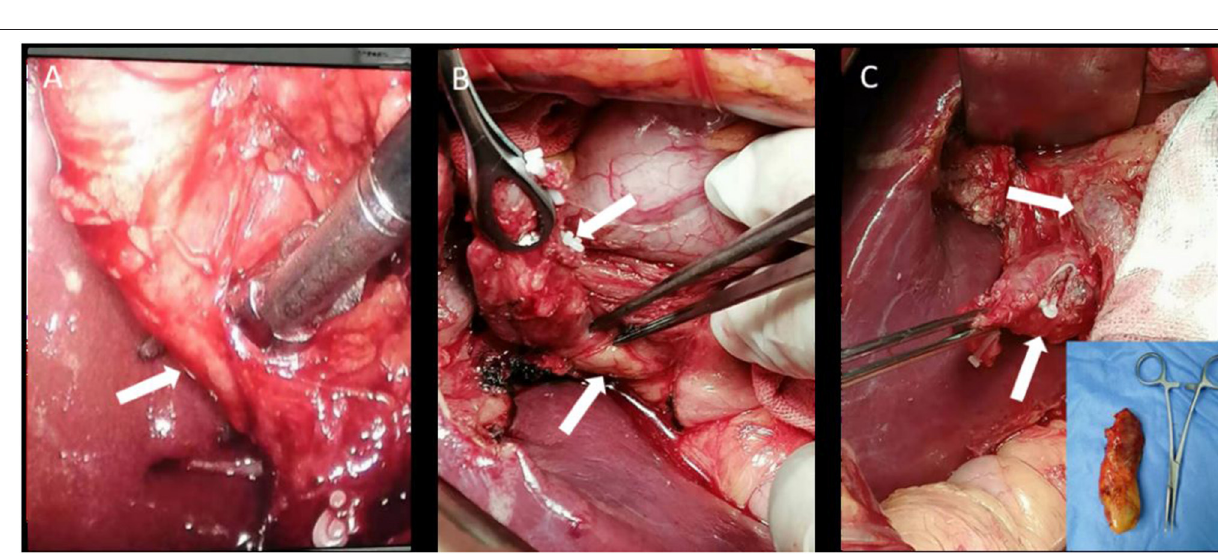
if the drainage to the bile duct is through a narrow neck and the extrahepatic bile duct is not cystic. The second is a cholecystectomy with excision of the extrahepatic bile duct